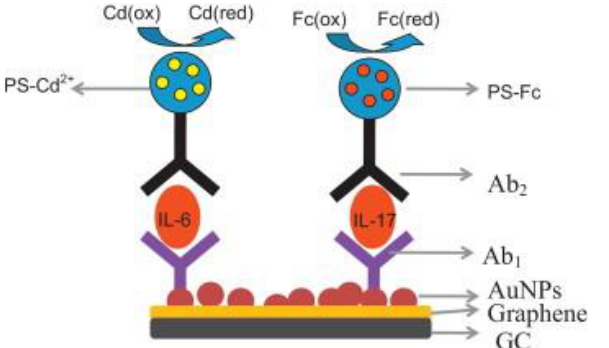
Figure 16. Schematic illustration of a PS-Cd 2+ -anti-IL-6 Ab, PS-Fc-anti-IL-17 Ab immunosensor for multiplexed detection of IL-6 and IL-17. Upon sandwich immunoreaction, two current peaks are generated with SWV, corresponding to the reduction in Cd 2+ and Fc. Reprinted from [153] with permission from Elsevier.